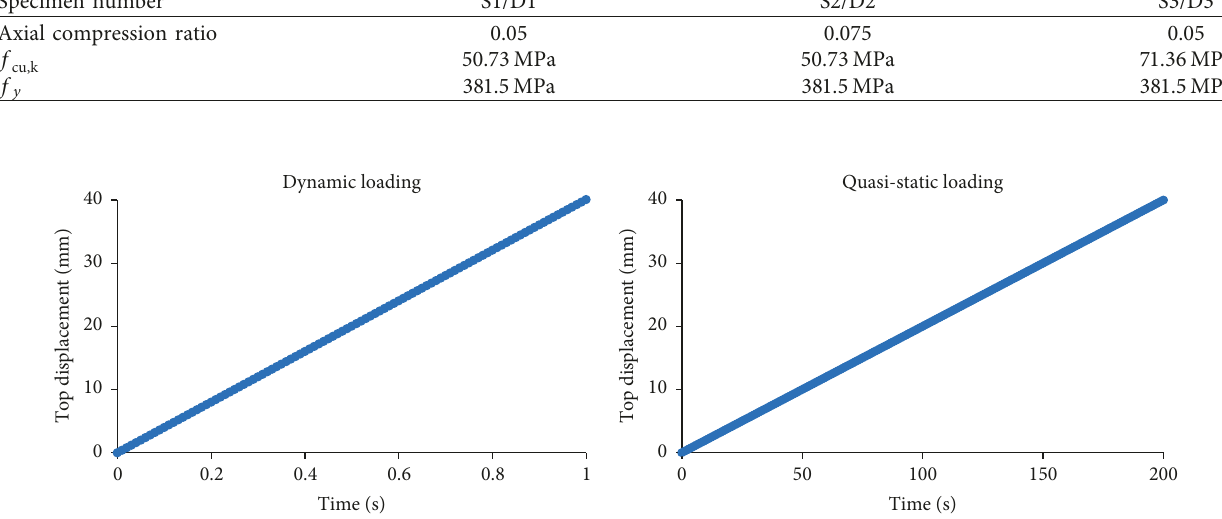
Figure 5: Loading